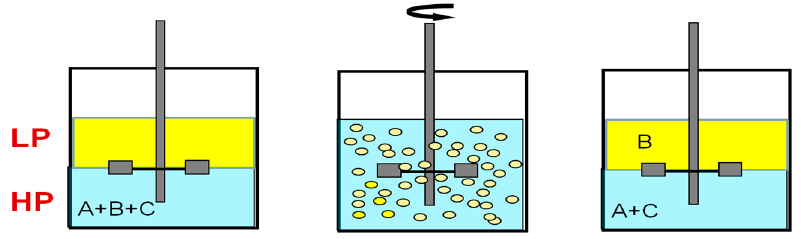
Figure 1. General scheme of extraction processes. A–C—components of the mixture.